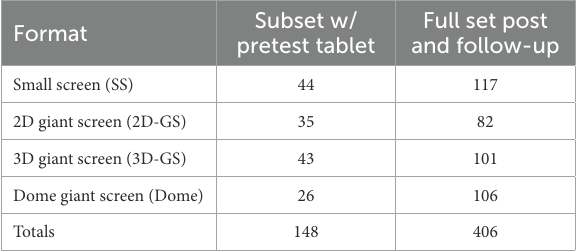
TABLE 2 Number of participants by format – Subset and Full